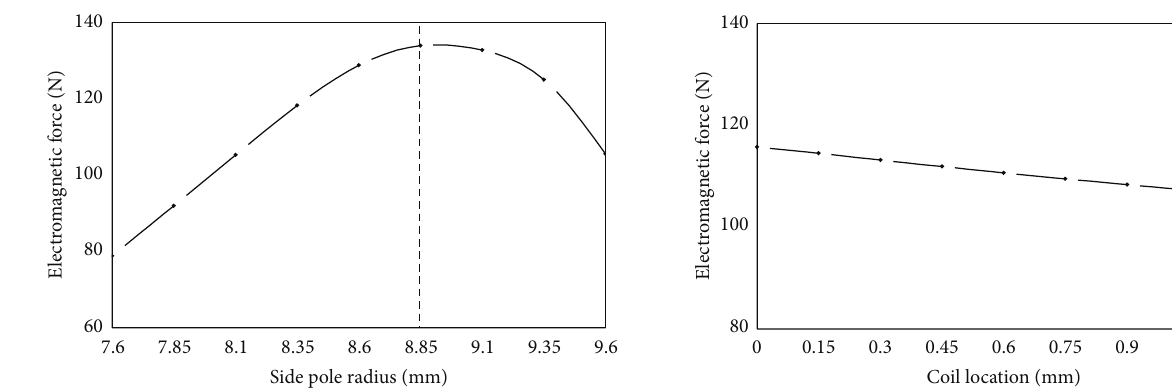
Figure 10: Influence of side pole radius on electromagnetic force.